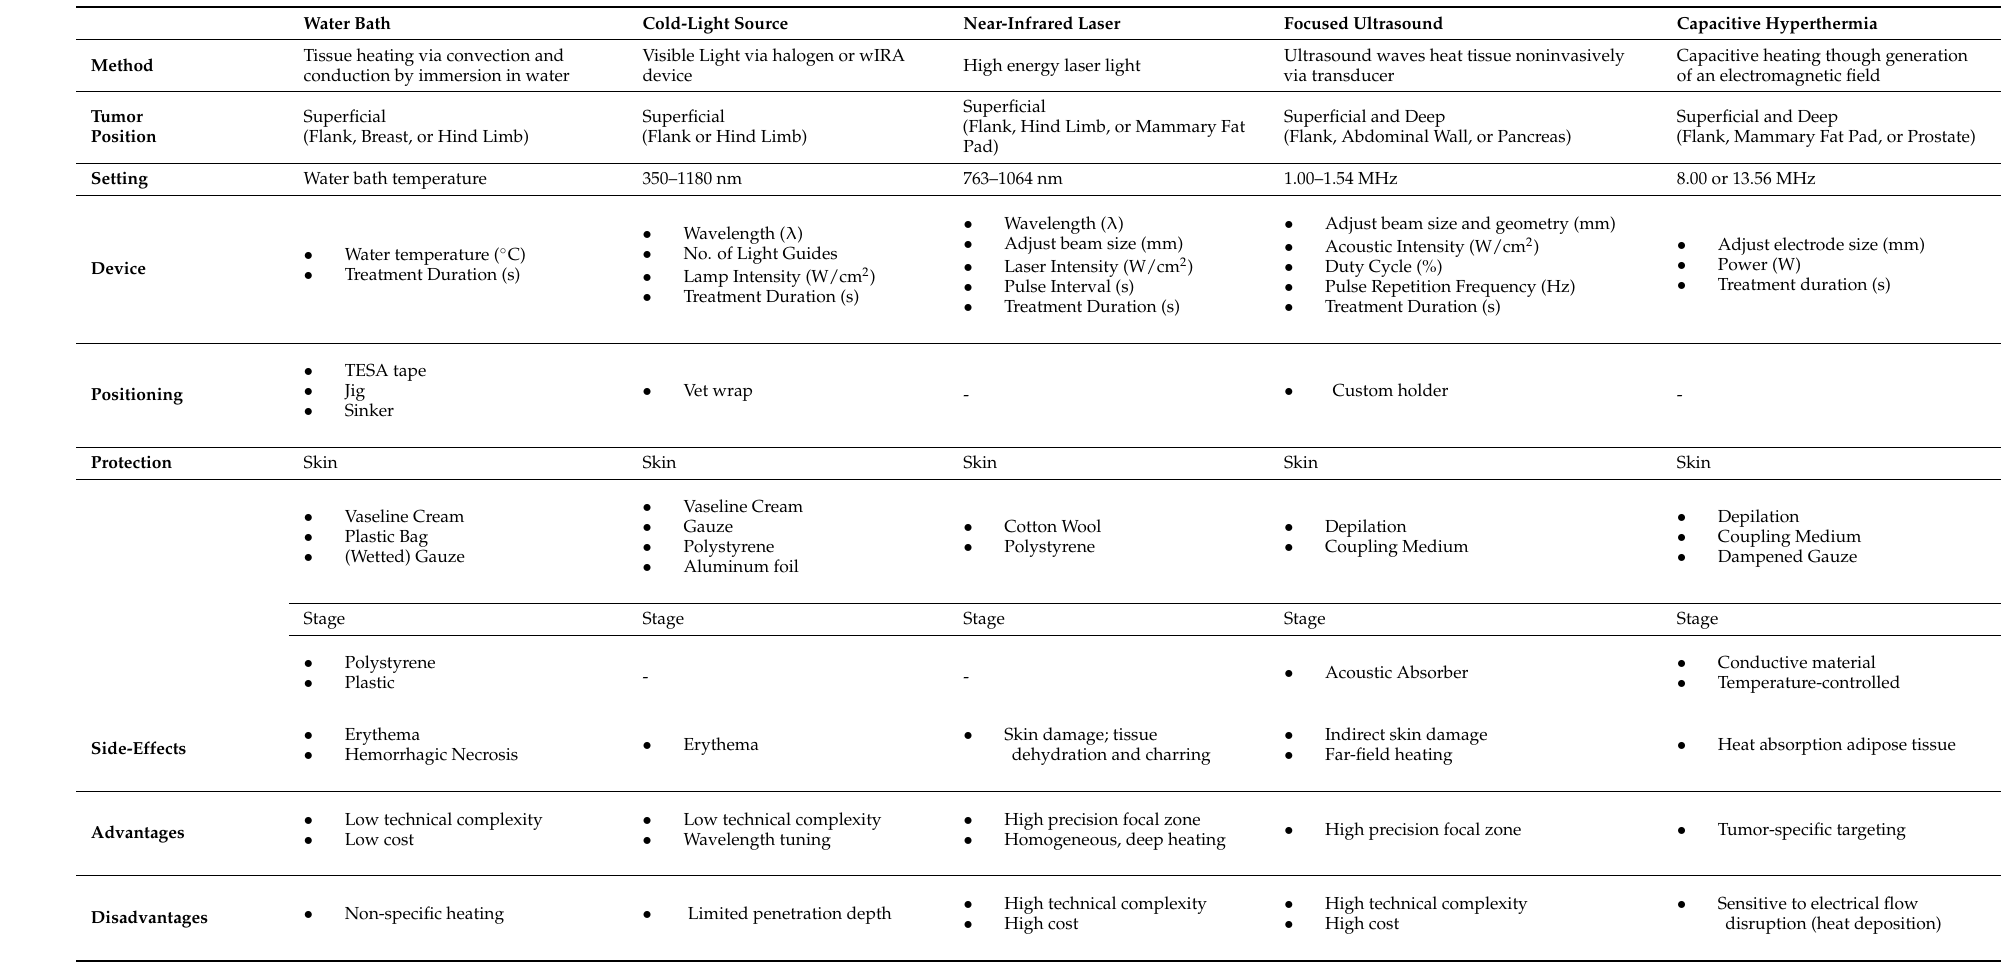
Table 6. Overview of the basic hyperthermia devices for preclinical small animal